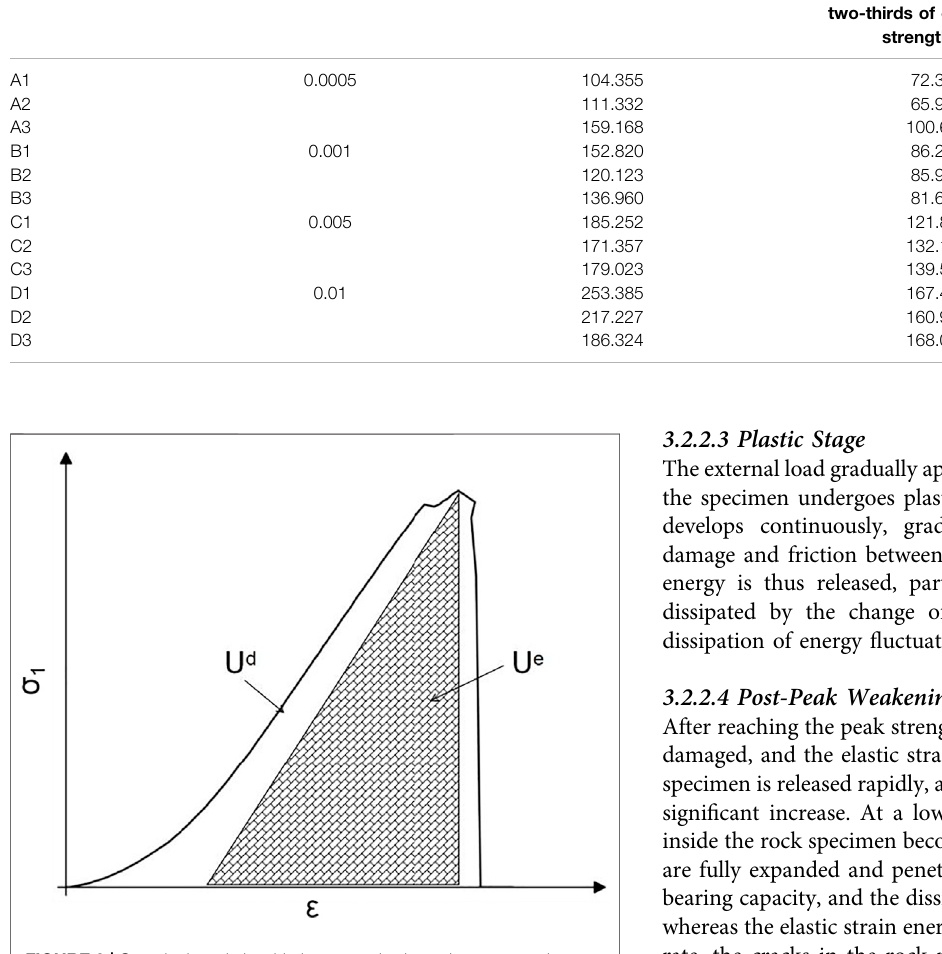
FIGURE 9 | Quantitative relationship between elastic strain energy and damage dissipation energy.